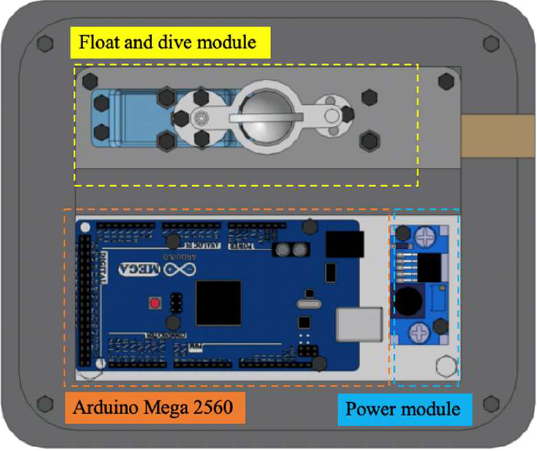
Figure 2. Interior layout of the waterproof tank.